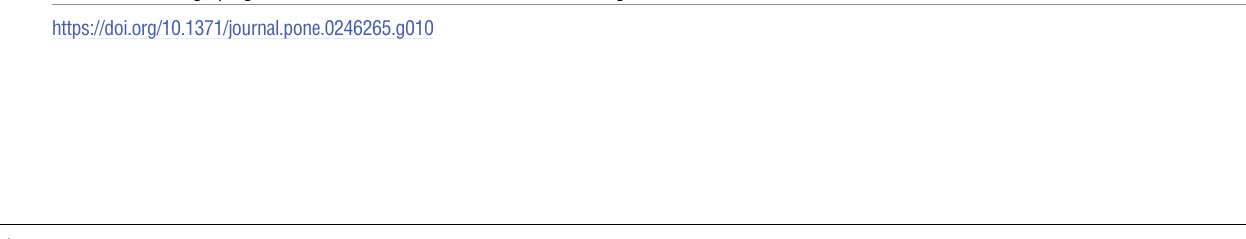
PLOS ONE | https://doi.org/10.1371/journal.pone.0246265 March 4,